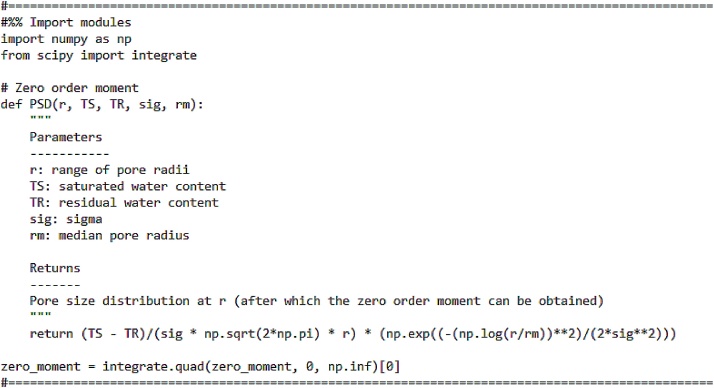
Code for zero-order moment.